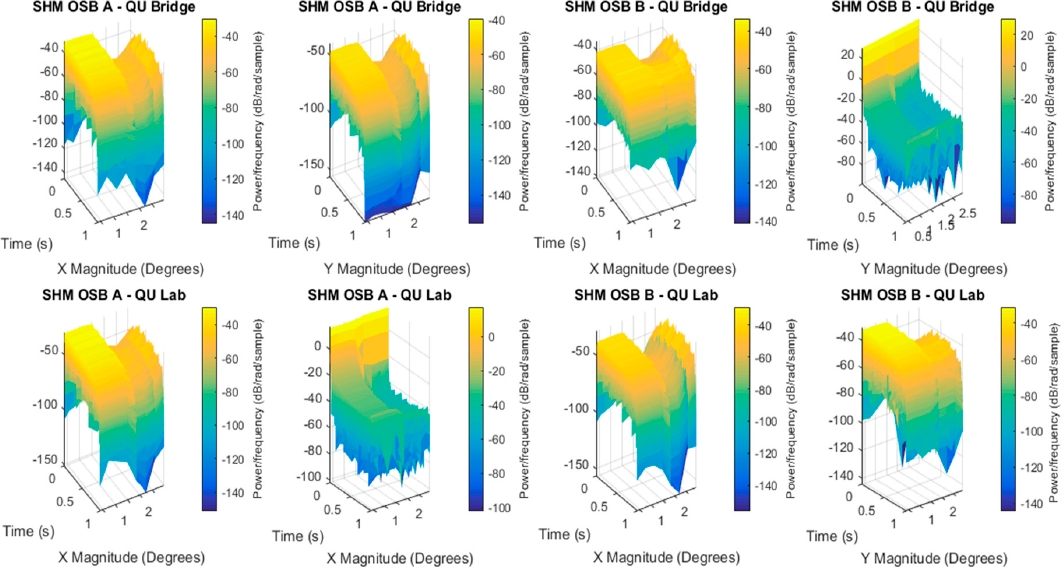
Figure 23. 3D spectrograms in the time domain from two SHM sites (QU Bridge and QU Lab).